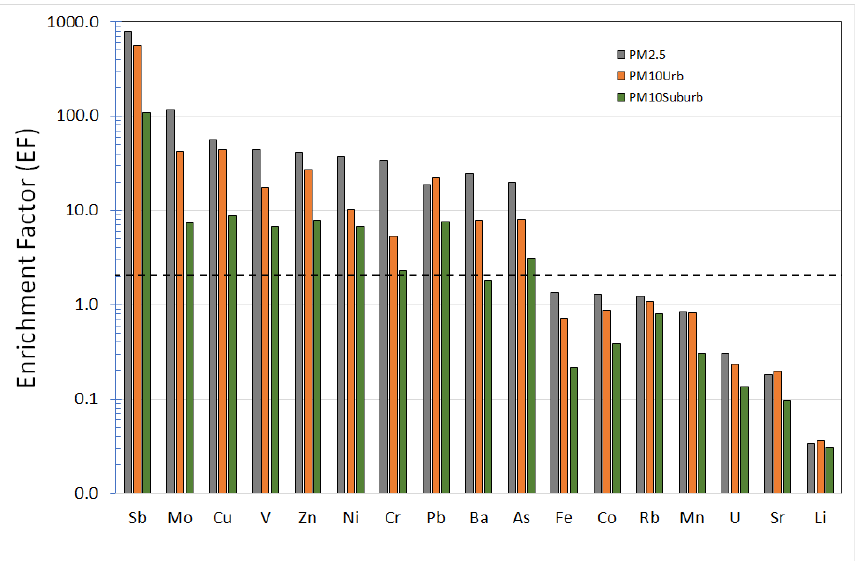
Figure 3. Average enrichment factors (EFs) for the analyzed elements in PM 2.5 and PM 10 samples. The dashed line indicates the boundary between enriched and non-enriched.